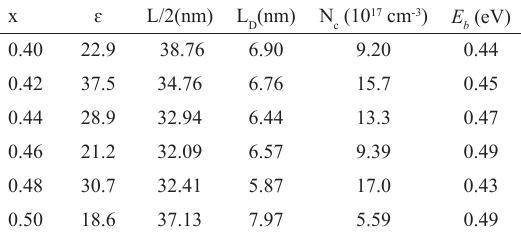
Figure 4: Temperature dependence of electrical resistivity plotted as ln(ρT−1/2) vs. 103/T of samples Mn Table 2: Parameters of the grain/barrier model for all Mn samples. x is the composition factor, the ɛ relative dielectric constant, the half of the average crystallite size ( L/2 ), Debye shielding Length ( L ). The last two columns are related to the ability of carriers D to cross such barriers, i.e. N energy barrier height).